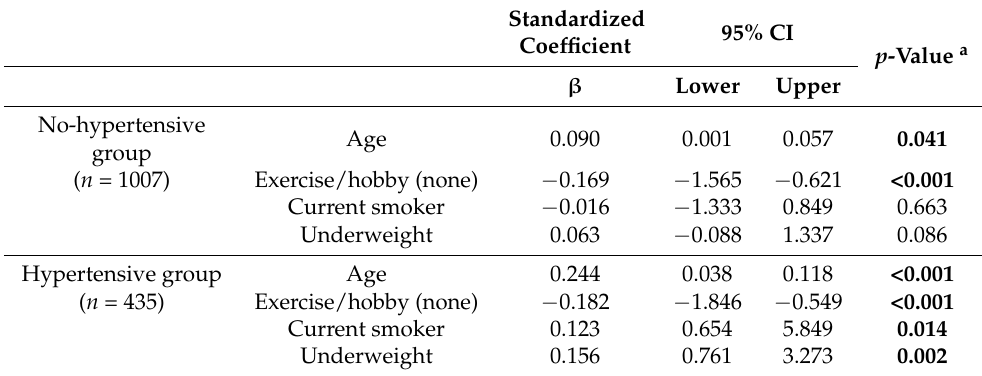
Table 6. Relationship between underweight and GDS stratified by hypertension in